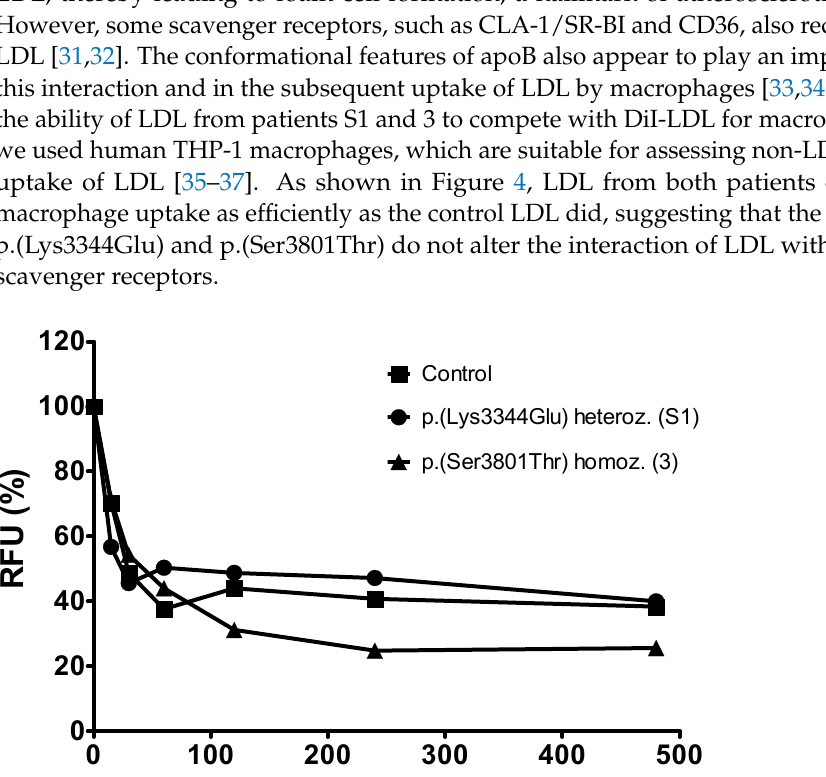
Figure 5. Ability of LDL from apoB p.(Lys3344Glu) heterozygous patient S1 to support U937 cell proliferation. [Methyl- 3 H]thymidine incorporation into DNA was measured in disintegrations per minute (DPM). Data represent the mean ± SEM of four replicates and are representative of two in- dependent experiments with similar results ( p < 0.001). The identi fi cation of the p.(Lys3344Glu) car- rier is indicated in brackets (see text).